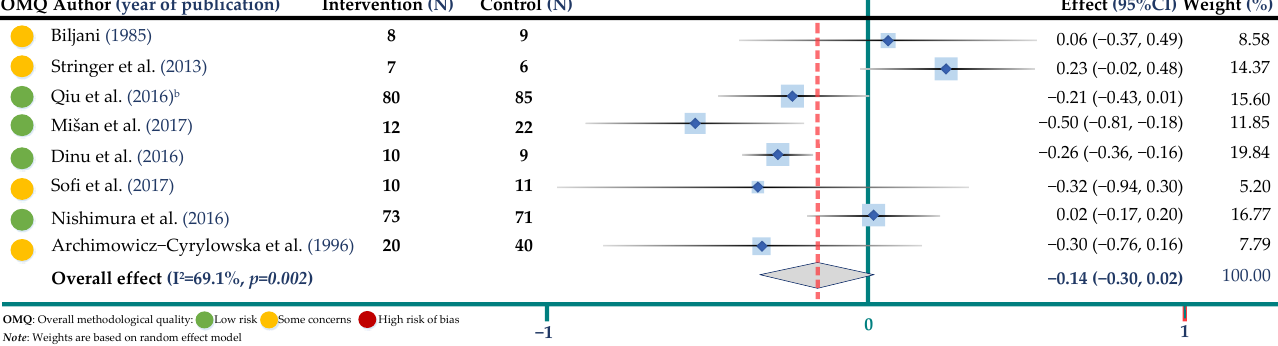
Figure 3. Meta-analysis of buckwheat supplementation and triglycerides. b indicates the Qiu study according to Table 2 [17,18,20,22,25,28,31,32]. Stratified analyses showed (Table S4) that for TC, WMD was significant in the case of studies conducted in Europe (WMD = −0 .28 mmol/L, 95% CI: −0 .37; −0 .187, I 2 = 0%, p = 0.57), including more than 50% female participants (WMD = −0 .23 mmol/L, 95% CI: −0 .41; −0 .05, I 2 = 59.6%, p = 0.04) or conducted among unhealthy participants (WMD = −0 .28 mmol/L, 95% CI: −0 .37; −0 .19, I 2 = 69.1%, p = 0.002), while null association was observed among the strata of other study characteristics. Most of the interventions (5/8) had mean value of TC out of the normal range at baseline in the intervention arm (Table S5). For TG, WMD was consistent across all subgroup analyses, while one single study involving both healthy and unhealthy subjects (i.e., mix) showed higher levels with BW intake (WMD = 0.19 mmol/L, 95% CI: 0.03; 0.35).